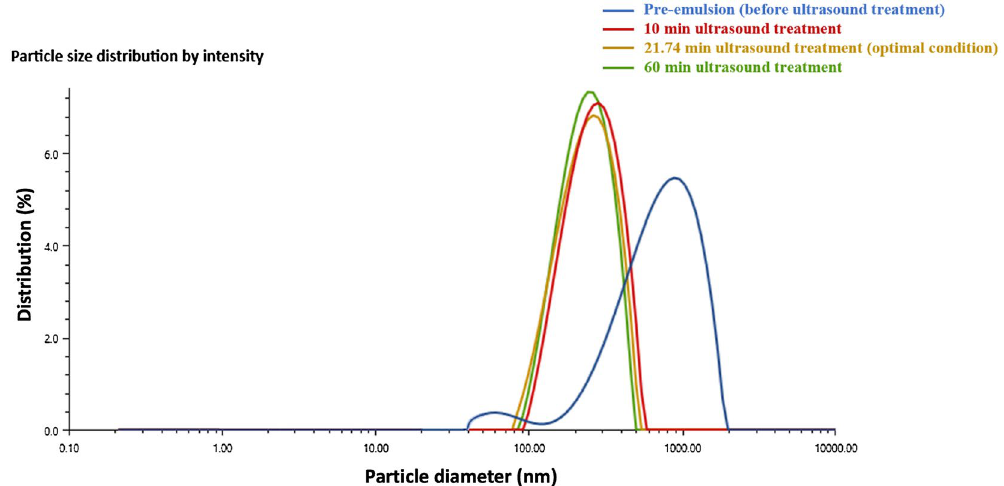
Figure 2. ( a ) Correlation curves between processing time and particle size of samples with different volumes under various ultrasonic amplitudes. ( b ) Correlation curves between T opt and τ % (red shows samples processed at 25% amplitude; green shows samples processed at 50% amplitude; and blue shows samples processed at 100%